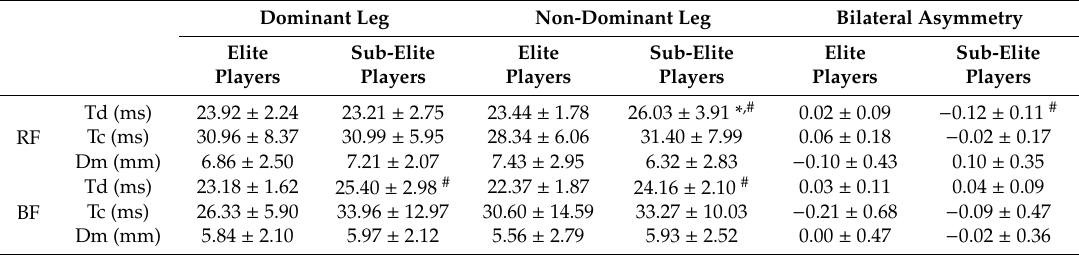
Table 2. Tensiomyography (TMG) values of rectus femoris and biceps femoris of dominant leg and non-dominant leg in elite and sub-elite futsal